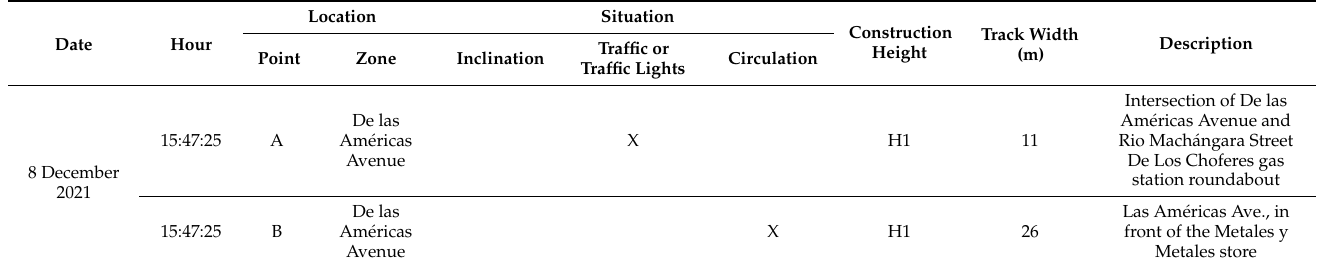
Table 3. Details of the di ff erent points (location, situation, construction height, track width).